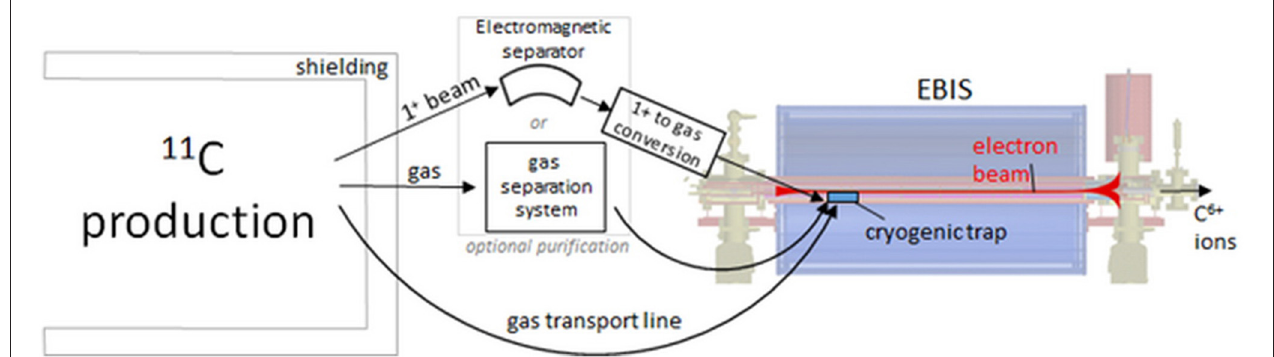
FIGURE 12 | Gas injection into the EBIS, equipped with a cryogenic trap. The radioactive gas (CO or CH 4 ) coming from the production target is transported into the EBIS, where it is accumulated in a cryogenic trap that releases the molecules through pulsed heating into the electron beam. If the level of contamination of other gases is too high for the EBIS, either a gas separation system or separation of a 1 + beam, in analogy to the ISOL-method, could be applied to purify the target output before injecting into the EBIS [adapted from